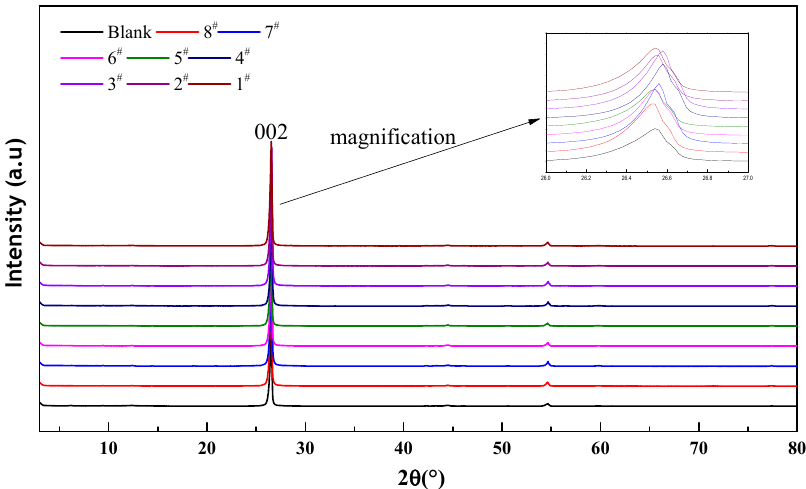
Figure 4. X-ray diffraction patterns of modified graphite.